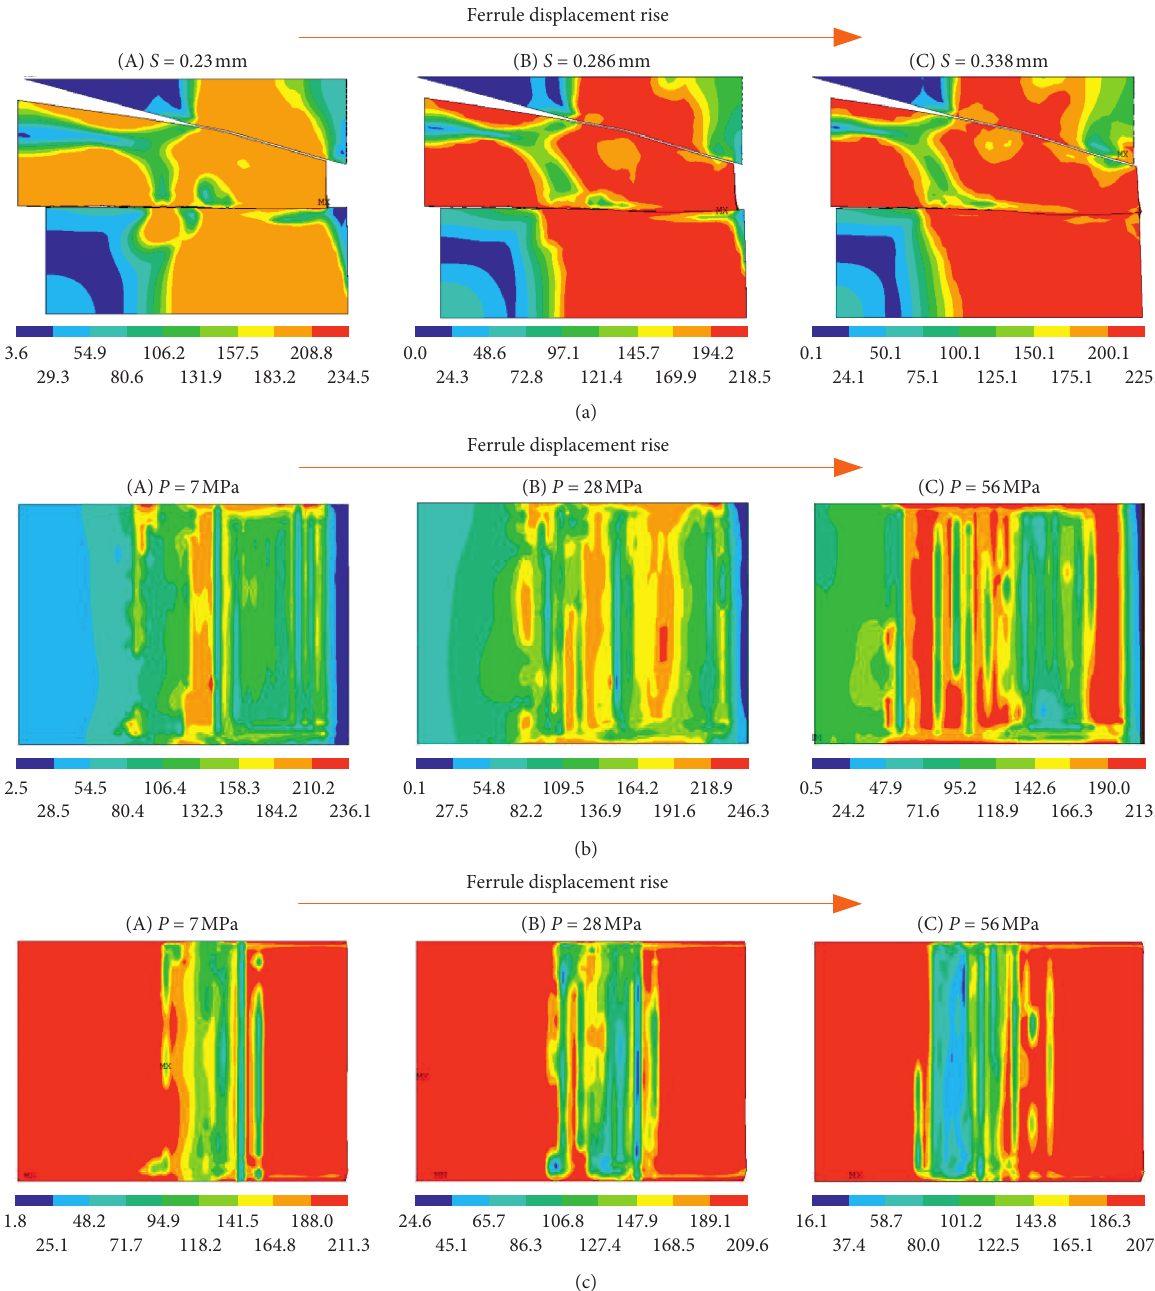
Figure 7: Stress distribution of fittings under different fluid pressures. (a) Seal state of fittings. (b) Stress distribution of pipeline surface. (c) Stress distribution of ferrule